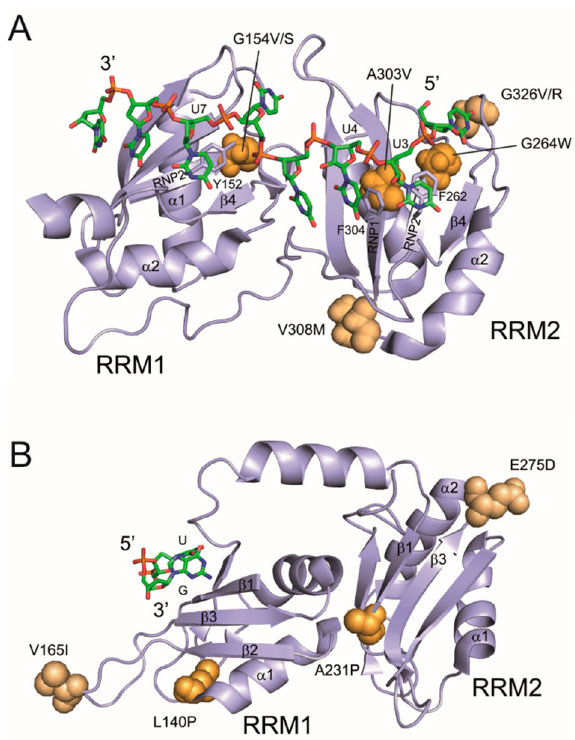
Figure 8. Cancer-associated substitutions mapped on to high-resolution RRM structures. ( A ) Crystal structure of U2AF65 tandem RRMs bound to poly(U) RNA (PDB entry 5EV1) [35] . ( B ) Crystal structure of PUF60 tandem RRMs bound to a modified AdML 3 ′ ss analogue (PDB entry 5KW1, Crichlow G. V. et al., unpublished). ( A , B ) Mutated residues (labeled) are shown as space-filling atoms. Substitutions that affected 3 ′ ss usage are in dark orange; substitutions that had no effect on minigene splicing are in light orange. Proteins (cartoon representation) are shown in purple. RNAs (stick representation) have carbon atoms in green, nitrogen atoms in blue, oxygen atoms in red and phosphorus atoms in orange.